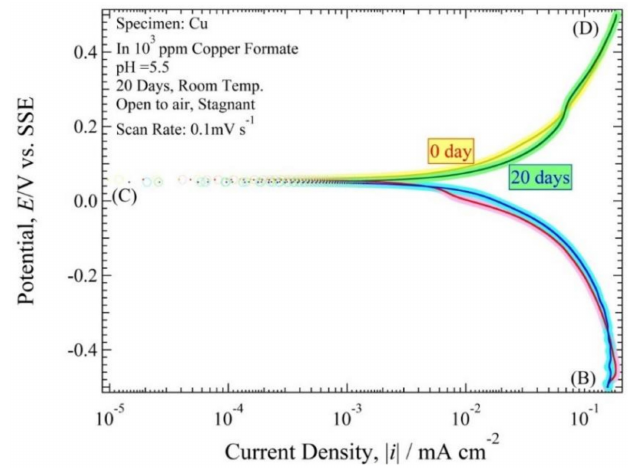
Figure 8. Polarization curve of Cu tube specimen in 10 3 ppm Cu(HCOO) 2 solution at the immersion period of 0 days and 20 days with solution pH 5.5.